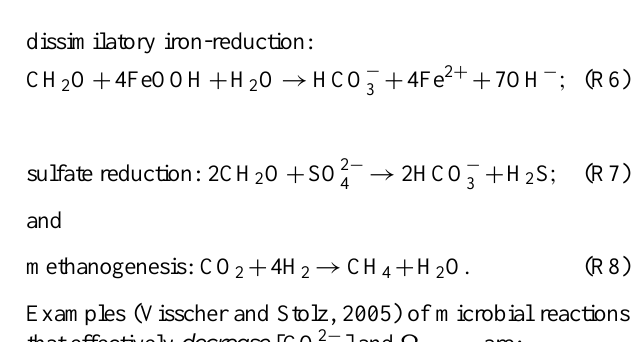
Table 3. Diversity of bacteria in biofilm communities determined by 16S rRNA gene sequence analysis.